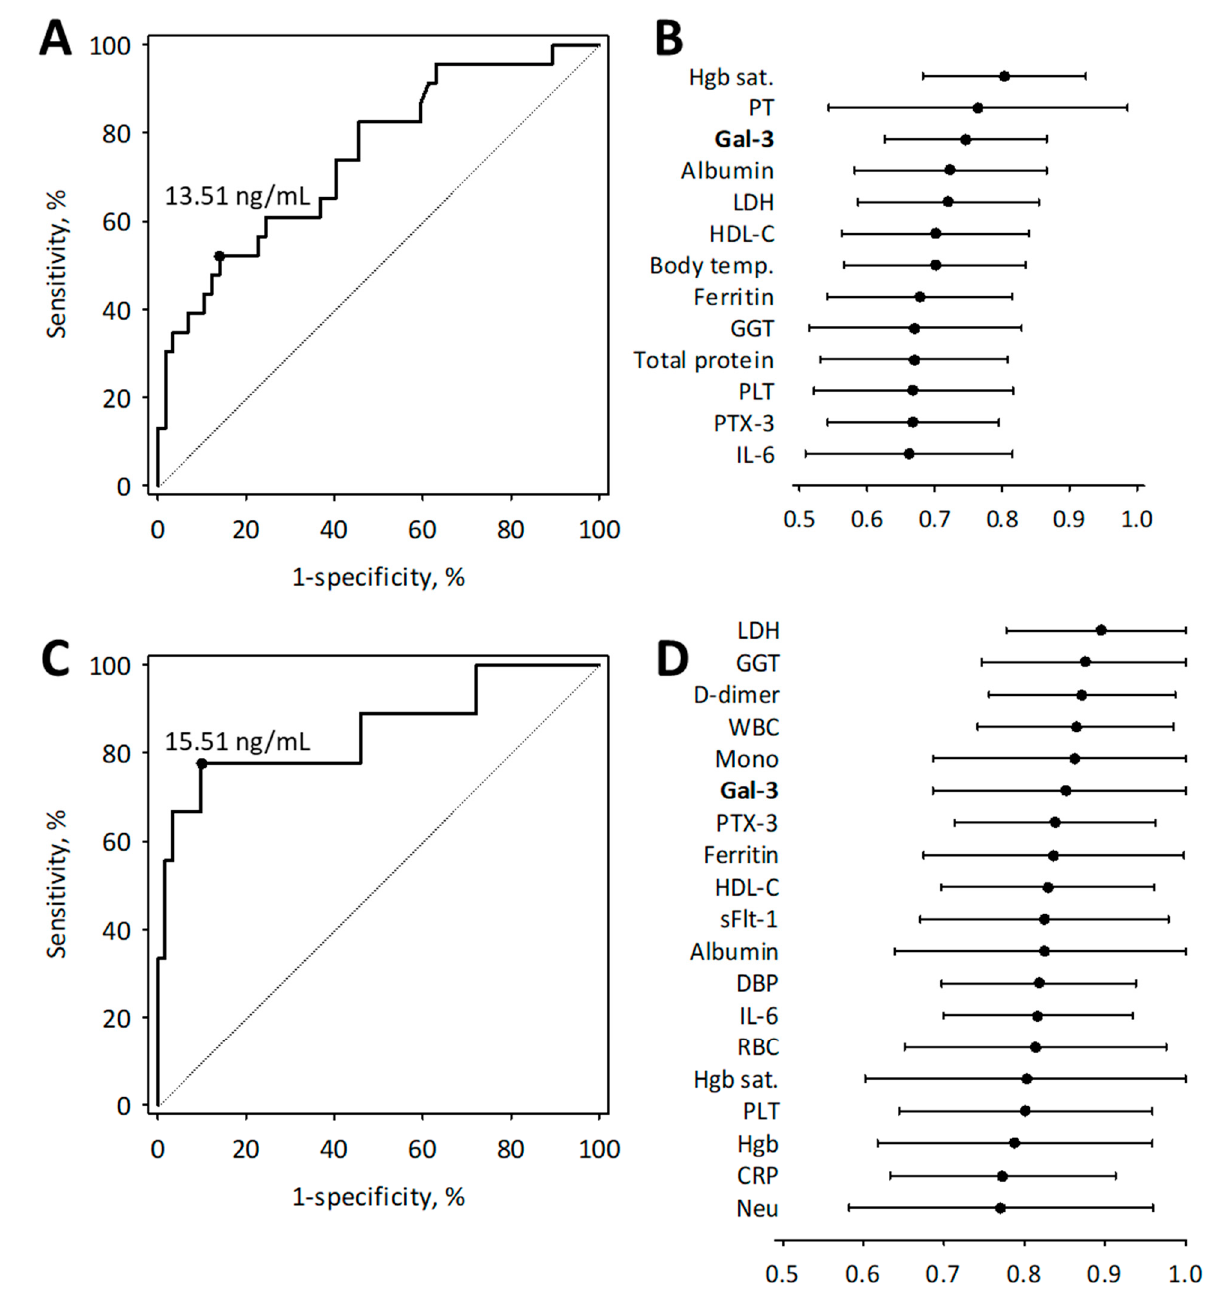
Figure 3. The ROC curves showing the diagnostic accuracy of serum galectin-3 concentrations for the diagnosis of COVID-19 pneumonia ( A ) and the need for of ICU admission ( C ) together with the cut-off values selected using the maximum Youden index. The comparison of area under the ROC curve values (AUC) of the tests with the diagnostic usefulness in the diagnosis of COVID-19 pneumonia ( B ) and the need for ICU admission ( D ): the estimated AUC value (central points) are shown with the 95% confidence intervals (whiskers). Abbreviations: see Tables 1 and 2; Hgb sat., hemoglobin oxygen saturation; PT, prothrombin time; Gal-3, galectin-3; LDH, lactate dehydrogenase; HDL-C, HDL-cholesterol; temp., temperature; GGT, gamma-glutamyl transferase; PLT, platelet count; PTX-3, pentraxin-3; IL-6, interleukin-6; Mono, monocyte count; DBP, diastolic blood pressure; Hgb, hemoglobin; CRP, C-reactive protein; Neu, neutrophil count.